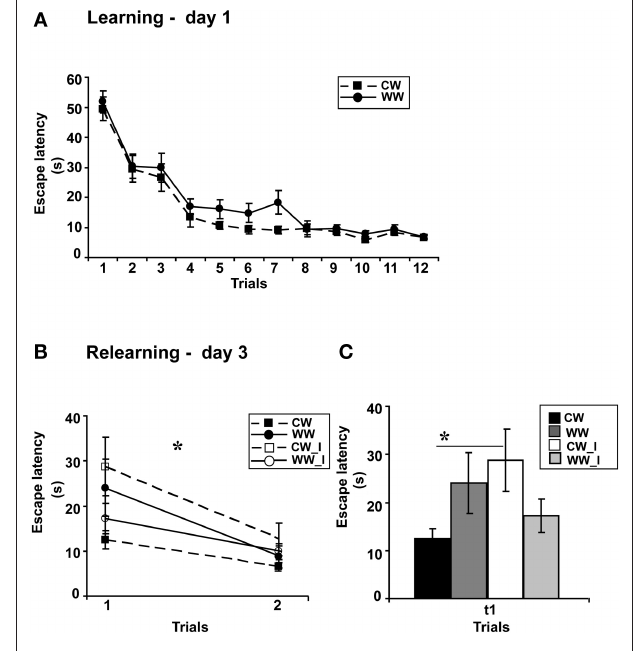
Figure 2 | Spatial memory formed in the Morris water maze under different stress conditions, warm (24 ± 1ºC) and cold (19 ± 1ºC) water, when interfered by a foot shock stress. (A) Mean escape latencies during the 4 final trials of initial training did not differ between WW and CW animals; (B) The foot shock interference procedure impaired memory retention as tested on day 3 (during relearning) in CW animals, but not in WW animals; (C) The mean escape latency of the cold water animals following interference during the first trial was significantly longer than that of the cold water group that experienced no interference (* p < 0.05). (CW, Cold water; WW, Warm Water; CW_I, Cold Water with interference; WW_I, Warm Water with